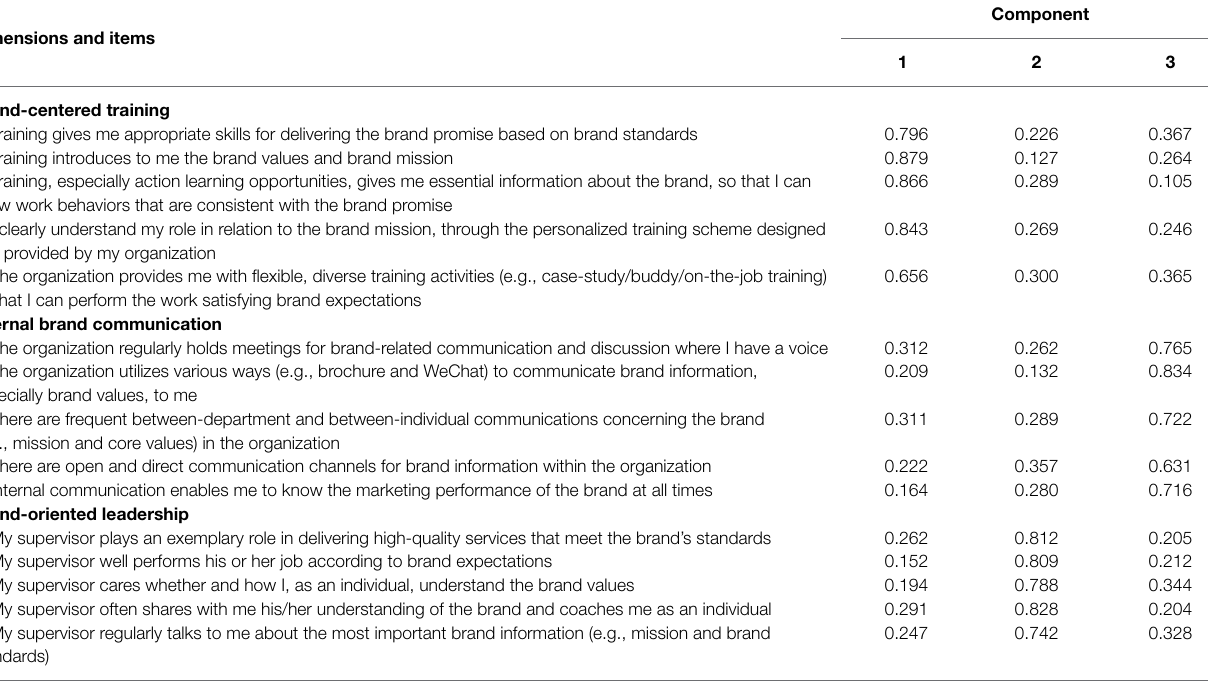
TABLE 1 | A principal component analysis of the 15-item nonprofit internal branding (NIB) scale.